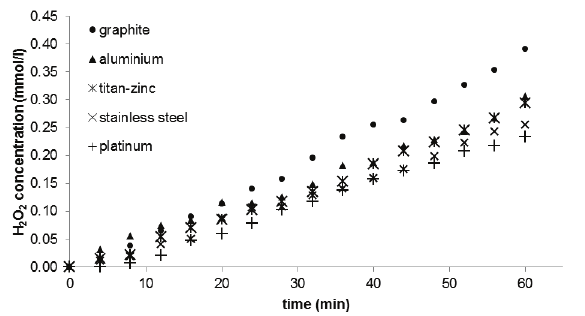
Figure 3 : Comparison of hydrogen peroxide production, various